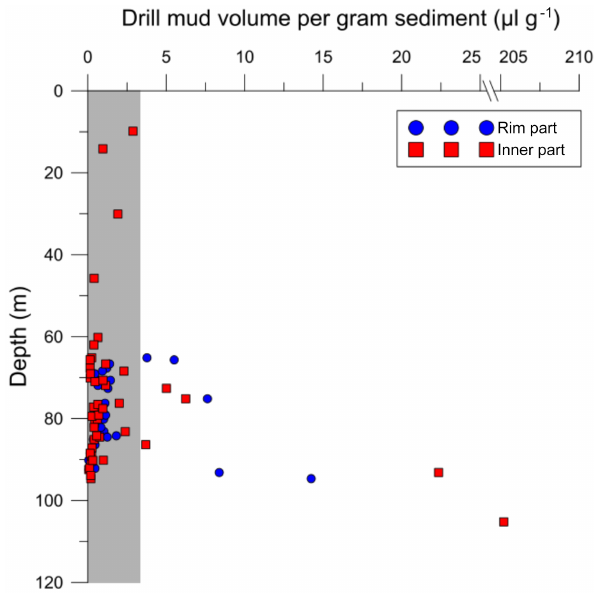
Figure 10. Contamination assessment of drill mud in cores. The grey area indicates the background noise of the fluorometric mea- surements of fluorescein (evaluated with core material obtained at the same site but without addition of fluorescein). 5 out of 45 inner core samples (red squares) are contaminated by drill